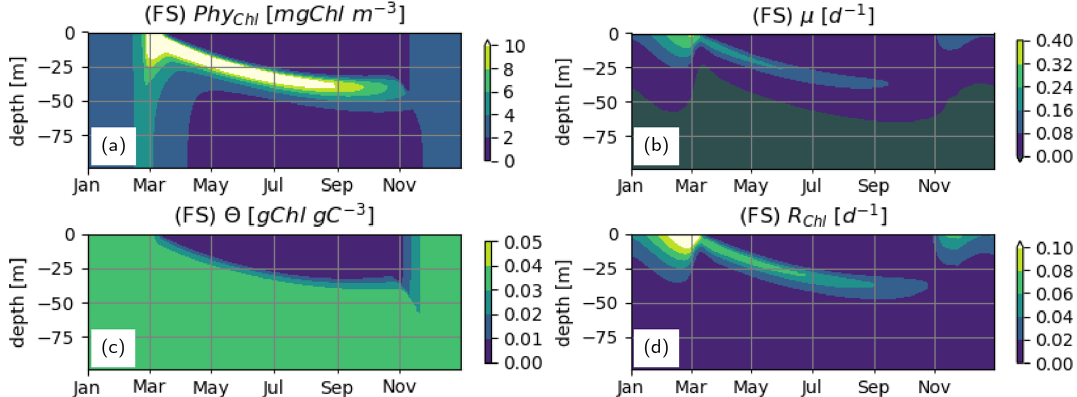
Figure B1. Phytoplankton (a) Chl concentration, Phy Chl [mgCm − 3 ]; (b) net growth rate, µ [d − 1 ]; (c) Chl : C, (cid:50) [gChlgC − 1 ]; (d) respiration cost of chlorophyll maintenance and synthesis, R Chl [d − 1 ] as simulated by the FS variant, when the prescribed (cid:50) (Table 3) is scaled with f C , according to Eq. (24).